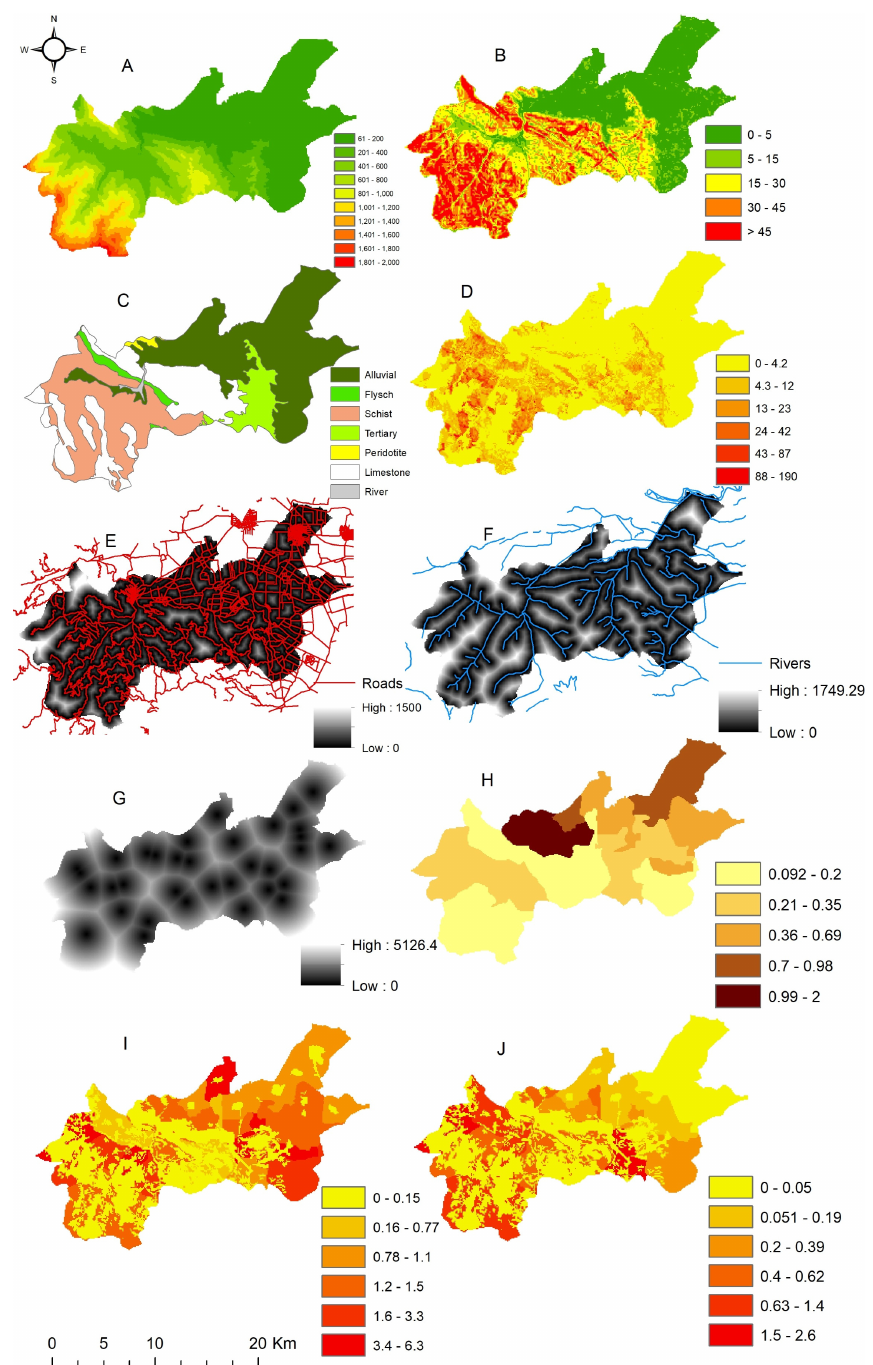
Figure 4. Landscape of Mouzaki. Spatial distribution of elevation classes (m, A ), slopes (%, B ), parent rock and soil depth ( C ), erosion potential (t/Ha/year, D ), distances from road network (m, E ), distances from hydrological network (m, F ), distances from urban centers (m, G ), inhabitant density (inh./Ha, H ), sheep density (head/Ha, I ), and goat density (head/Ha, J